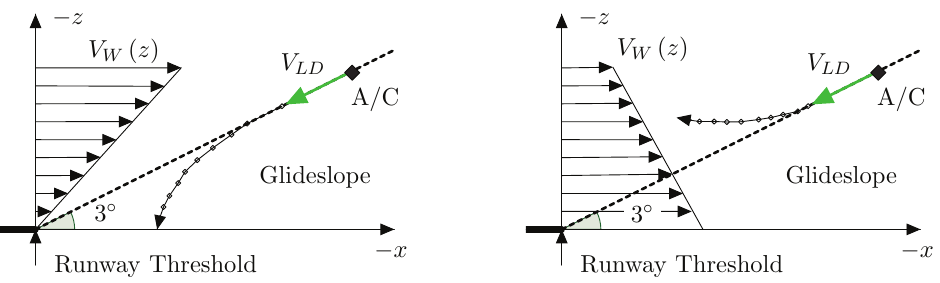
Figure 1. Effects of decreasing and increasing headwind shear on landing aircraft (after ICAO [2]). A/C is the aircraft, V LD the landing speed, and V W the headwind